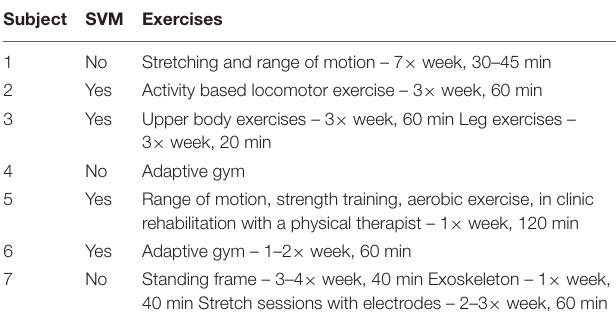
TABLE 2 | Weekly exercise schedule: reported exercises during study